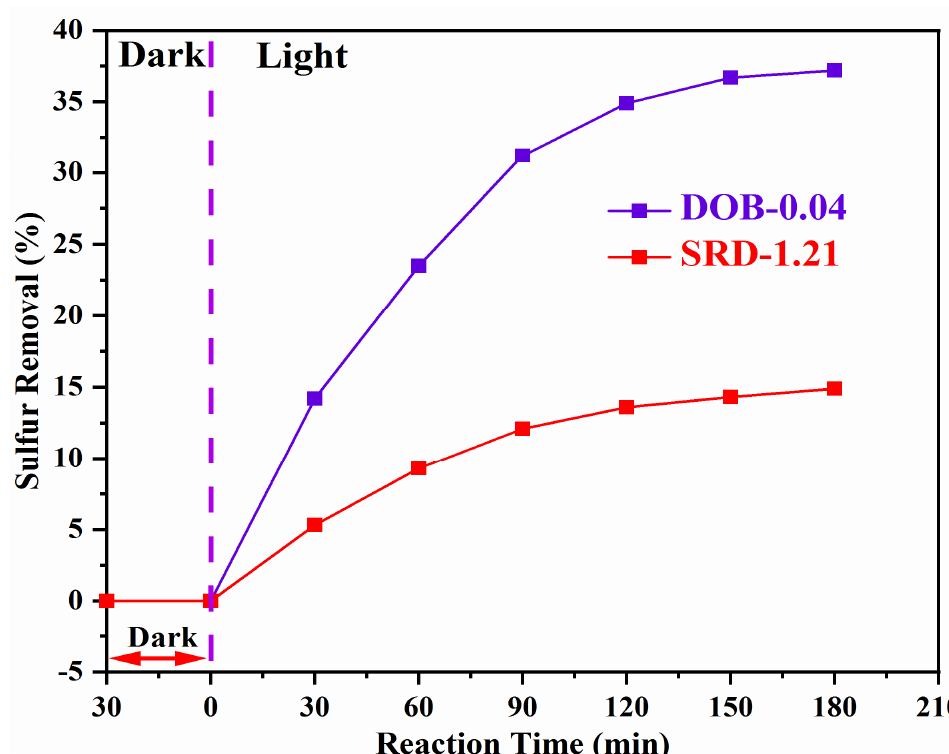
Figure 3. Photocatalytic desulfurization efficiency of V 2 O 5 photocatalyst for diesel oil using methanol as an interfacing agent.